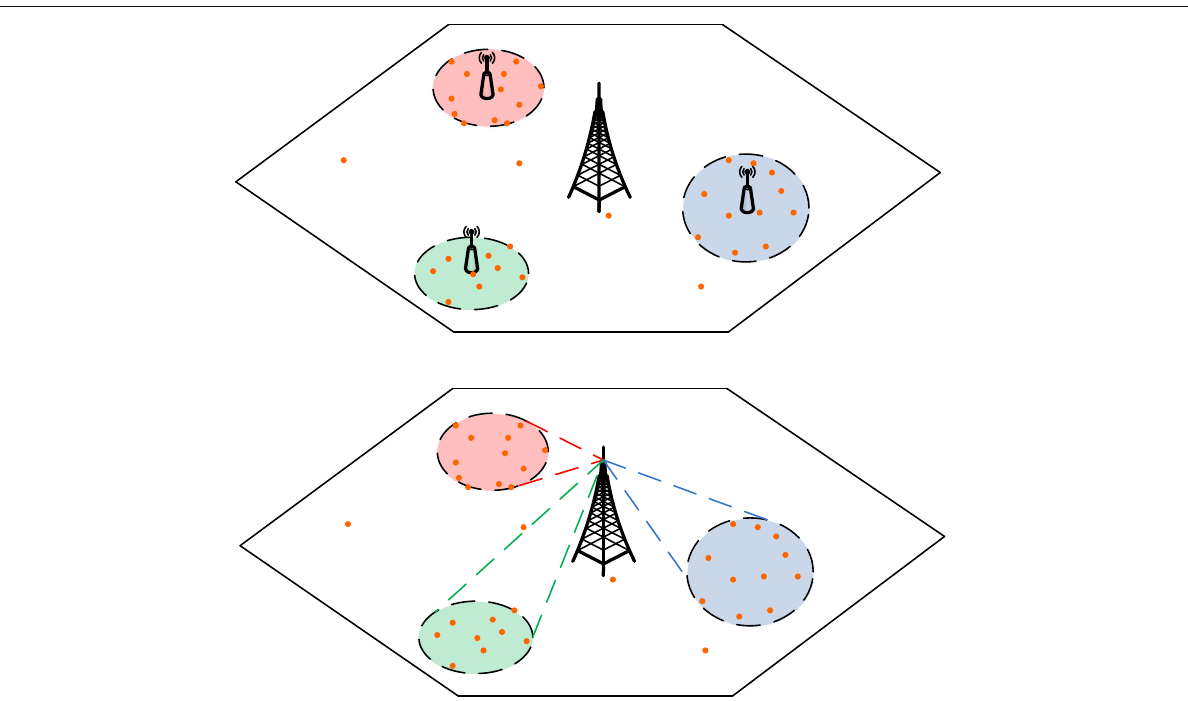
Fig. 6 Network topology with and without VSCs example. This figure illustrates the deployment of the VSCs (Fig. 4b Macrocell-VSCs scheme.) that could replace the physical small cells (Fig. 4a Macrocell-picocell scheme.), avoiding significant deployment cost for the operator